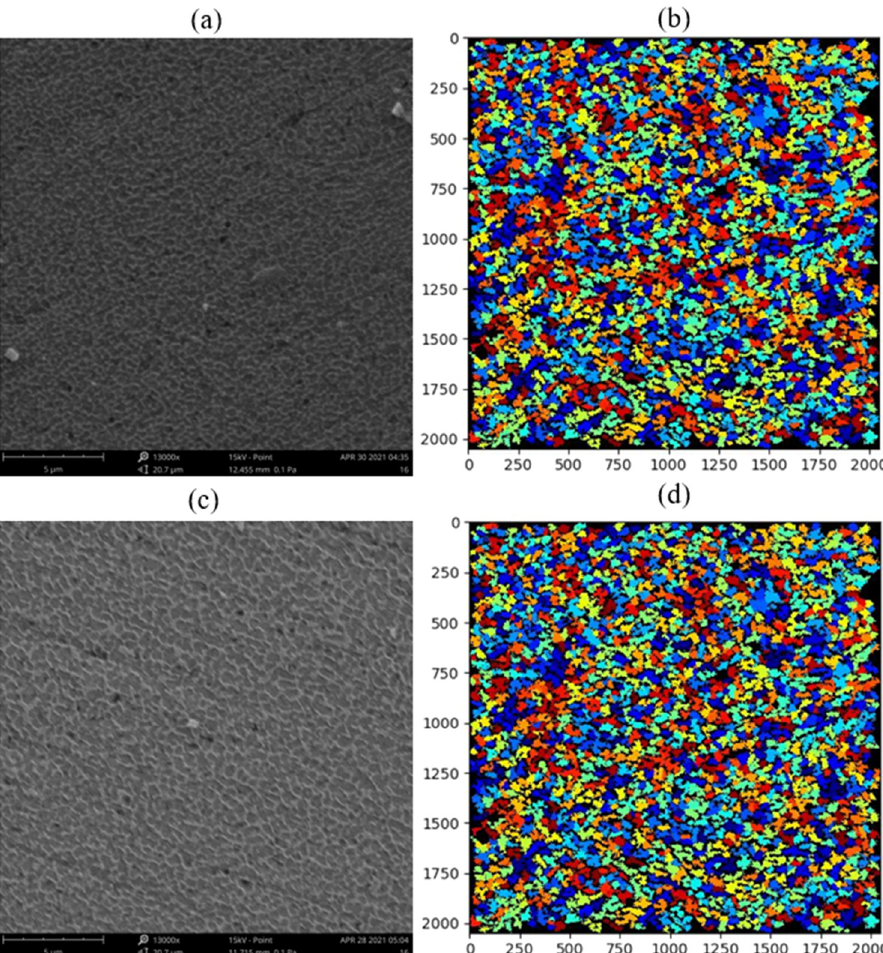
Figure 12: Low hardness ( 99.52 HV ) and high hardness ( 124.29 HV ) samples with good prediction accuracy: ( a ) and ( b ) low hardness sample ( sample no. 5 in Figure 11 ) SEM image and cell segmentation map; ( c ) and ( d ) high hardness sample ( sample no. 8 in Figure 11 ) SEM image and cell segmentation map.